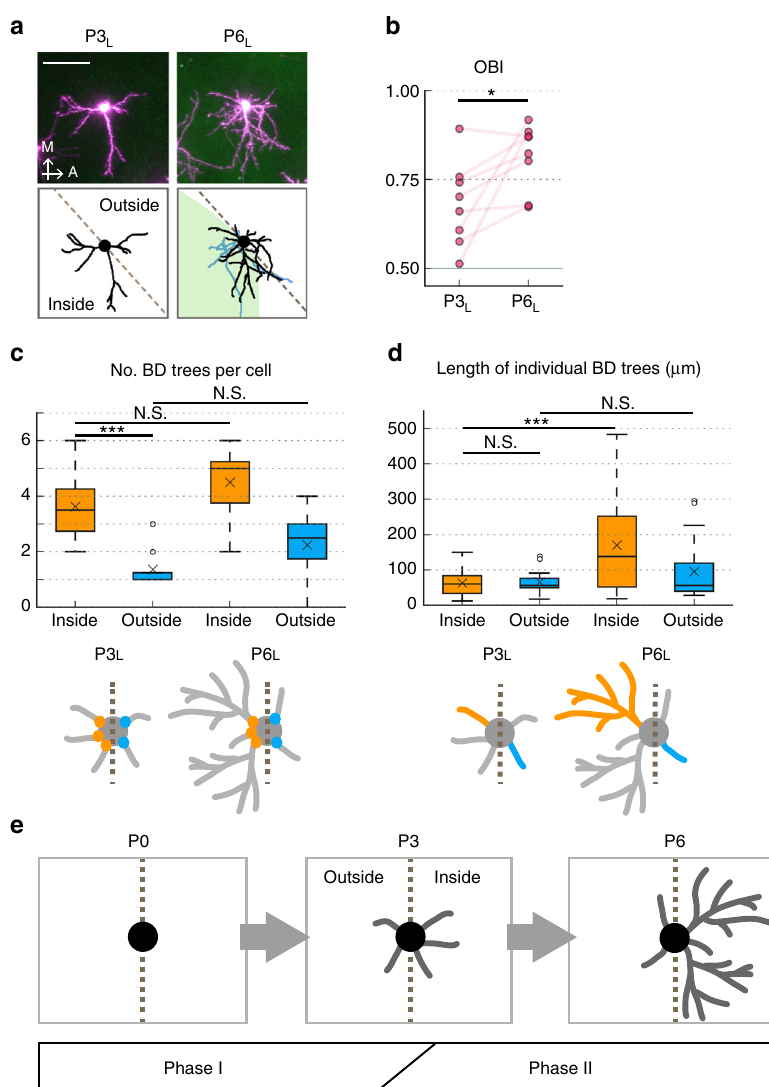
Fig. 3 eSS neurons increased BD orientation bias by inner BD tree-speci fi c elaboration. a (Top) Z-stack images of the same eSS neuron at P3 L and P6 L . (Bottom) BDs are traced. Green shade represents the TCA cluster. Dashed lines represent the border of inside/outside. Black, BDs; Blue, axons. Scale bar: 50 µ m. b eSS neurons increased OBI of BD between P3 L and P6 L ( p = 0.028, g = 1.244, n = 8 eSS neurons of 4 mice, Paired t -test). c (Top) At P3 L , the number of inner BD trees was signi fi cantly larger than that of outer ones ( p < 0.001, r = 1.974, Brunner – Munzel test). From P3 L to P6 L , there were no signi fi cant increases in BD tree number both inside ( p = 0.160, r = 0.317) and outside ( p = 0.137, r = 0.404, Wilcoxon signed-rank test). n = 8 eSS neurons of four mice. (Bottom) Schematics showing origins of inner (orange) and outer (blue) BD trees. Dashed line: inside/outside border. d (Top) The length of individual BD trees was similar between inside and outside at P3 L ( p = 0.809, g = 0.085, Welch ’ s t -test). The length of individual inner trees at P6 L was signi fi cantly larger than that at P3 L ( p < 0.001, g = 1.019, Welch ’ s t -test). On the other hand, there was no signi fi cant difference between the length of the individual outer trees at P3 L and that at P6 L ( p = 0.451, g = 0.401, Welch ’ s t -test). (Bottom) Schematics showing an inner tree (orange) and an outer tree (blue). Inner and outer trees are those whose origins are located inside and outside, respectively. Sample sizes are shown in Methods. p -values of c and d were corrected by Holm ’ s correction. Box plot interpretation is described in Methods. e eSS neurons establish BD orientation bias in neonatal stages through at least two distinct phases. During Phase I (approximately between P0 and P3), eSS neurons acquire the initial orientation bias, which is ascribed to the difference of BD tree number between inside and outside. In Phase II, starting approximately at P3, the number of BD trees is not much changed but BD orientation bias is reinforced by the differential elaboration of individual inner and outer BD